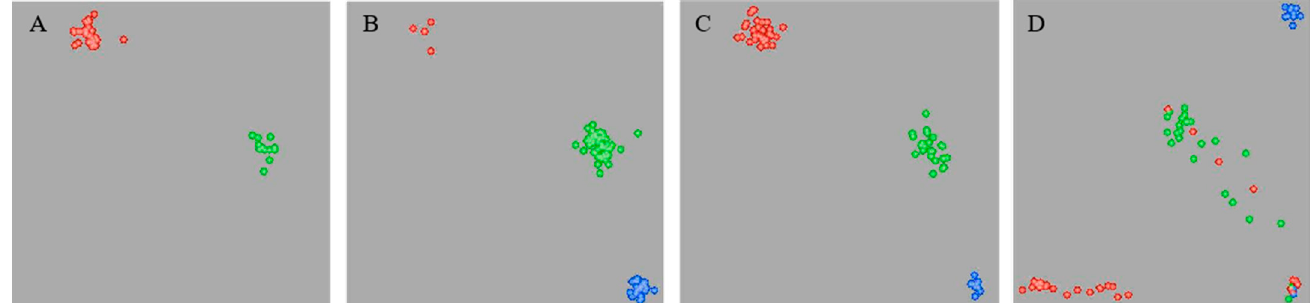
Figure 2. Verification of Sme2.5_01158.1_g00001.1 by KASP, the four charts represent four plates respectively. Red points indicate genotype A:A, green points indicate A:G, and blue points indicate G:G: ( A ) 10F 1 plants with the genotype A:G, 20 dwarf plants with genotype A:A of the F 2 population; ( B ) 4 dwarf plants with the genotype A:A of the F 2 population and 90 wild plants with the genotype A:G and G:G of the F 2 population; ( C ) 3 WT plants, 3 dwf plants, 14 dwarf plants with the genotype A:A of the M 3 population; ( D ) 16 dwarf plants with the genotype A:A of the M 3 population, 21 wild plants with A:G and 13 with G:G of the M 3 population, and 4 A:G of the F 2 population.